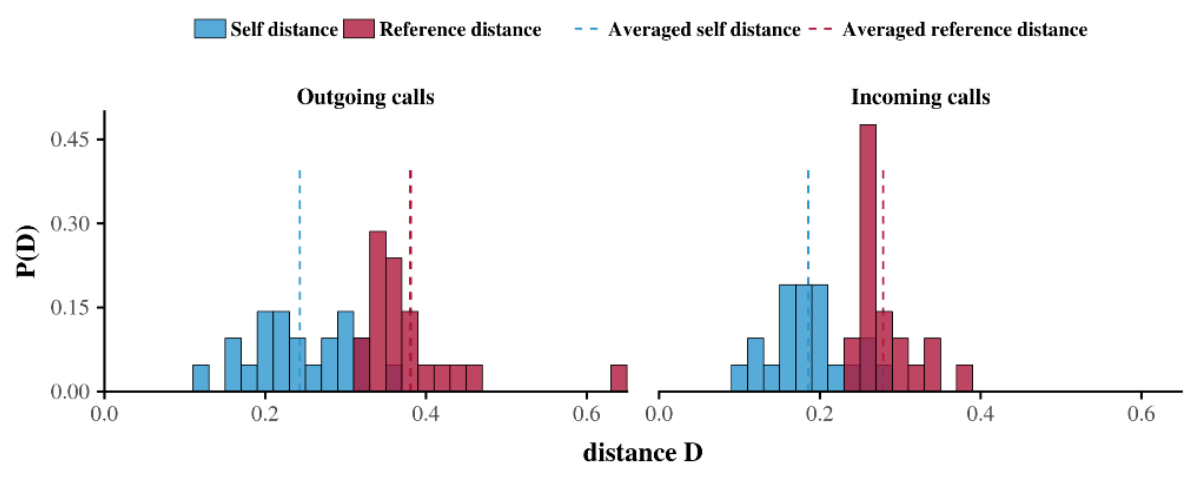
Figure 4. Average persistence histogram. Red bars represent the average reference distances, whereas blue bars represent the average self-distances for all egos in this study. Blue and red dashed lines represent the average reference distance and the average self-distance of the overall population, respectively. The results show that, on average, the self-distance of egos is less than their reference distance, which is evidence of circadian rhythms in telephone activity among older adults.